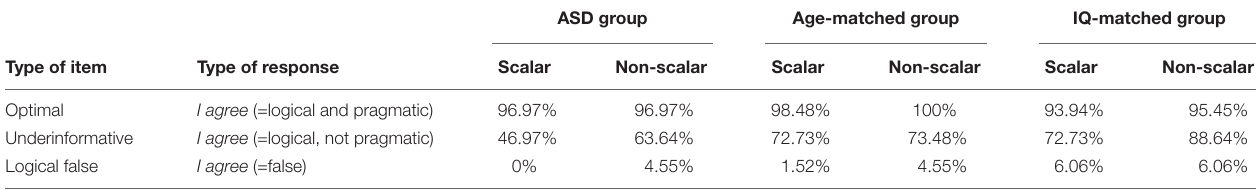
TABLE 2 | Experiment 1: percentage of I agree responses for the three item types.